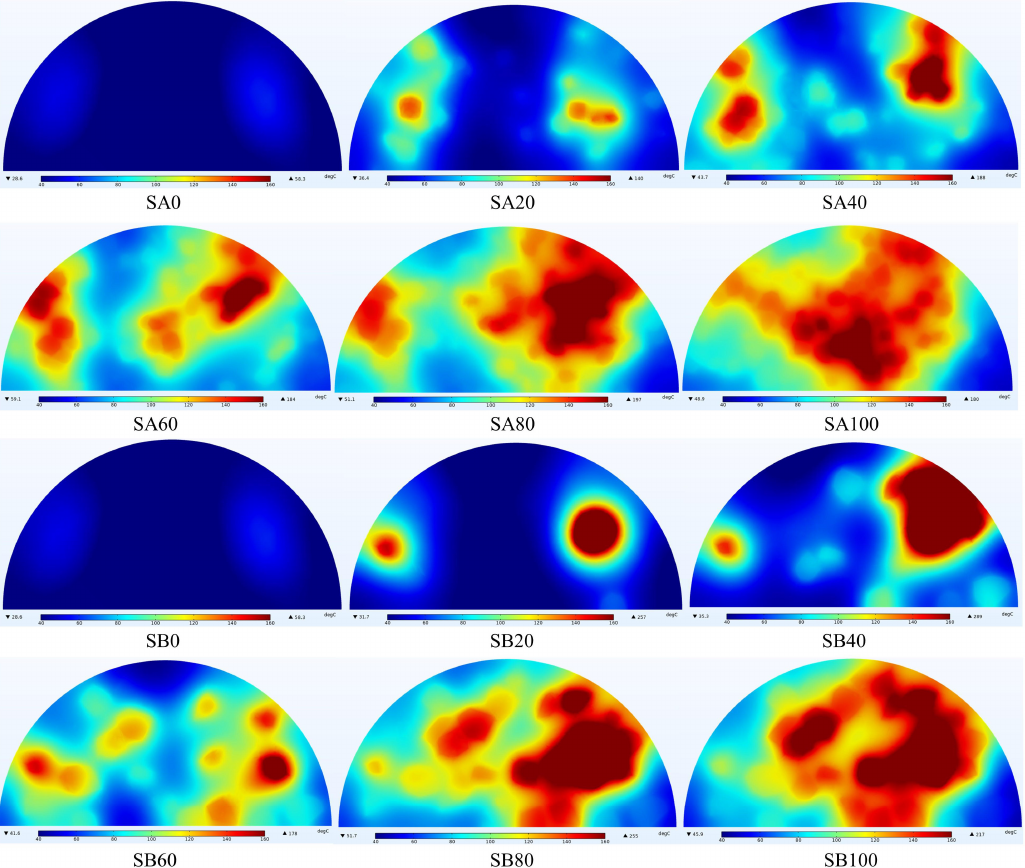
Figure 12. The thermal-field distributions of steel slag asphalt mixture center slices after 40 s of microwave heating.